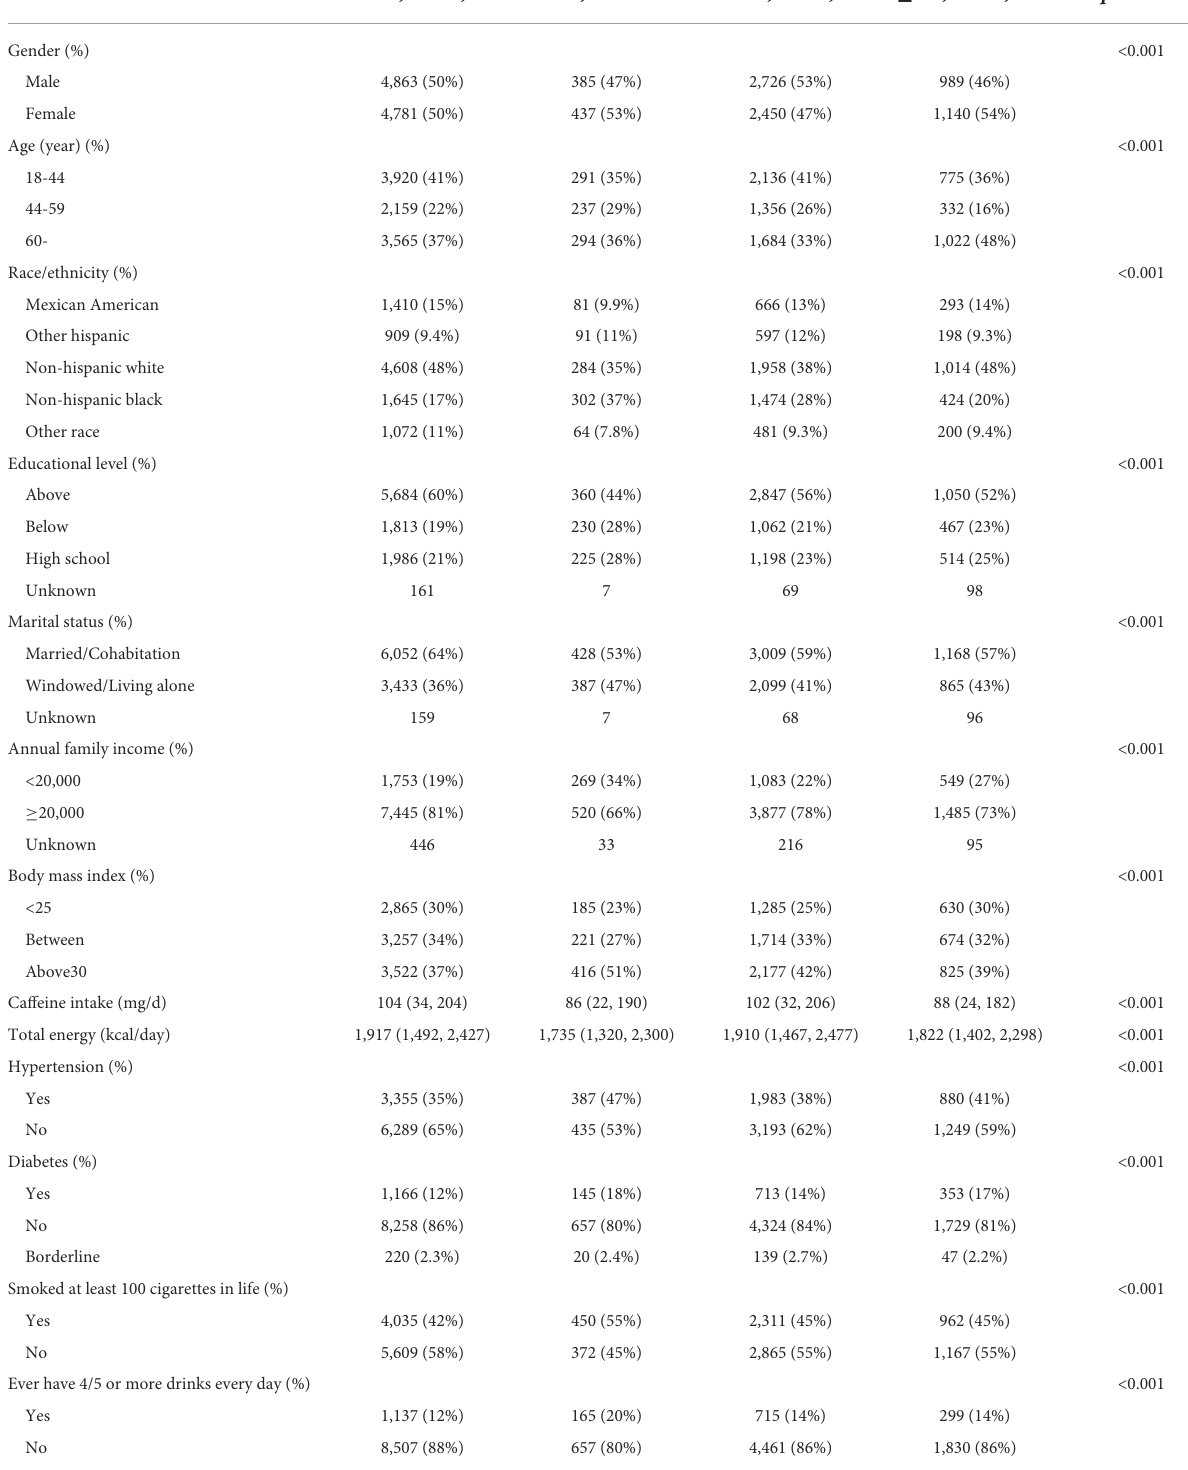
TABLE 2 Sample characteristics by sleep durations, NHANES 2007–2018 ( N = 17,771).